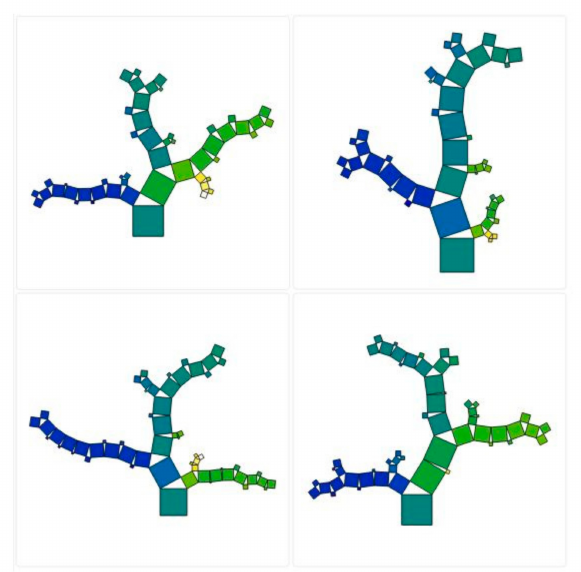
Figure 5. The structure of the RF model in predicting the punching shear capacity of steel fiber-reinforced concrete (SFRC) flat slabs.